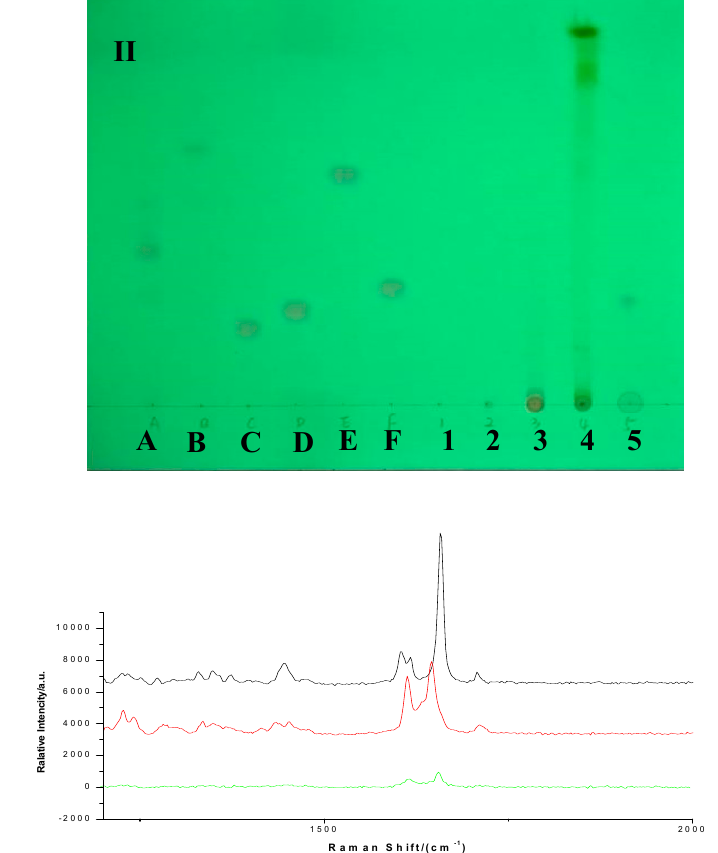
Figure 9. Five real samples used in TLC-SCRS detection ( I ), results from TLC analysis of five real samples developed with dichloromethane-acetone-methanol 12:2:0.5 ( v / v / v ) ( II ), (A–F: prednisone, prednisone acetate, prednisolone, hydrocortisone, hydrocortisone acetate, and dexamethasone